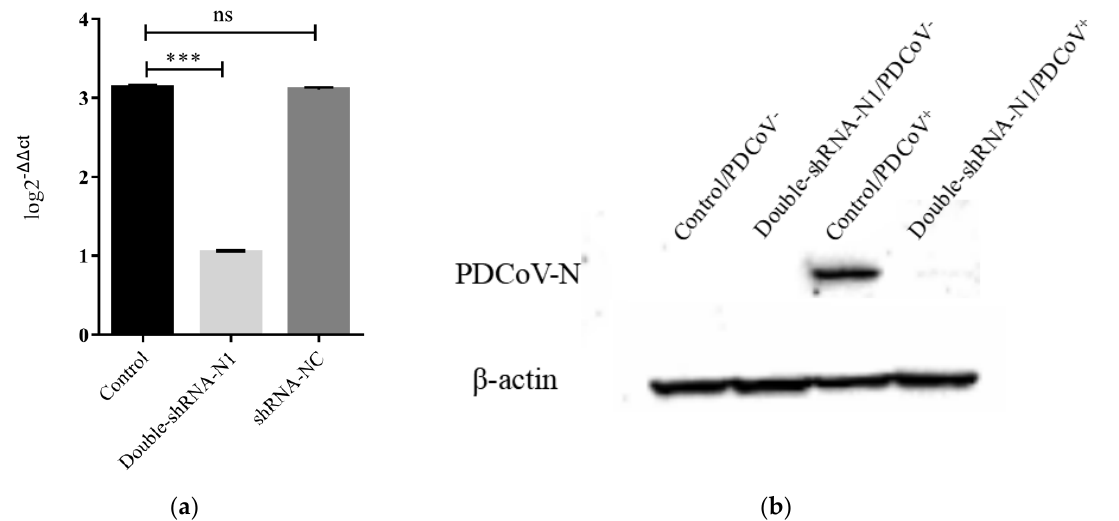
Figure 5. The reduction of PDCoV RNA and PDCoV N protein triggered by double-shRNA-N1-expressing plasmids. ( a ) qRT-PCR analysis of the inhibition of viral RNA synthesis in LLC-PK1 cells expressing double-shRNA-N1, the results are marked with three asterisks (***) if p < 0.001; ( b ) Western blot analysis of double-shRNA-N1-expressing plasmids inhibiting PDCoV N protein expression in LLC-PK1 cells at 36 hpi.